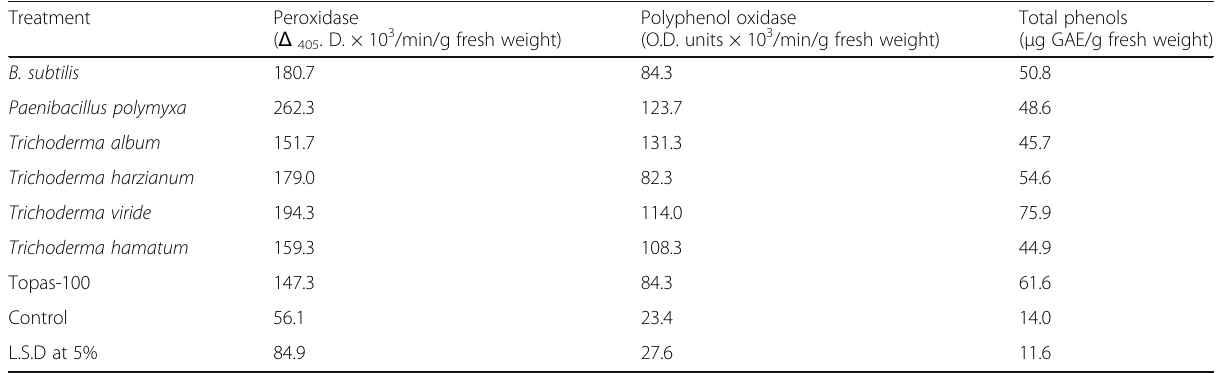
Table 3 Effect of some bio-agent on biochemical changes of squash plants